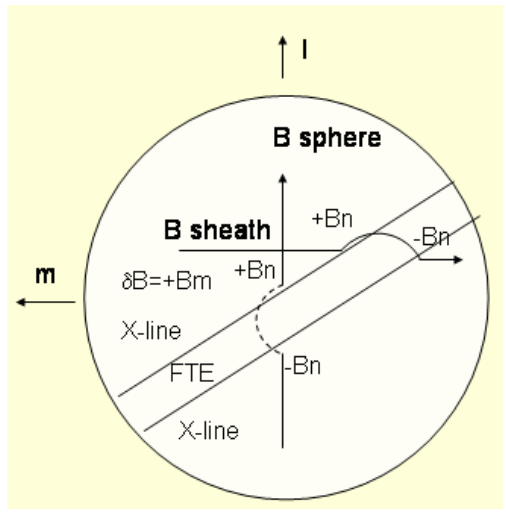
Fig. 1. Predictions for the perturbations associated with an FTE gen- erated between two parallel component reconnection lines. Recon- nection (X) lines (and corresponding FTEs) tilt from southern dawn to northern dusk for duskward IMF orientation ( − Bm). The (north- ward) magnetospheric magnetic field drapes dawnward under FTEs that tilt from southern dawn to northern dusk (dotted curve in fig-